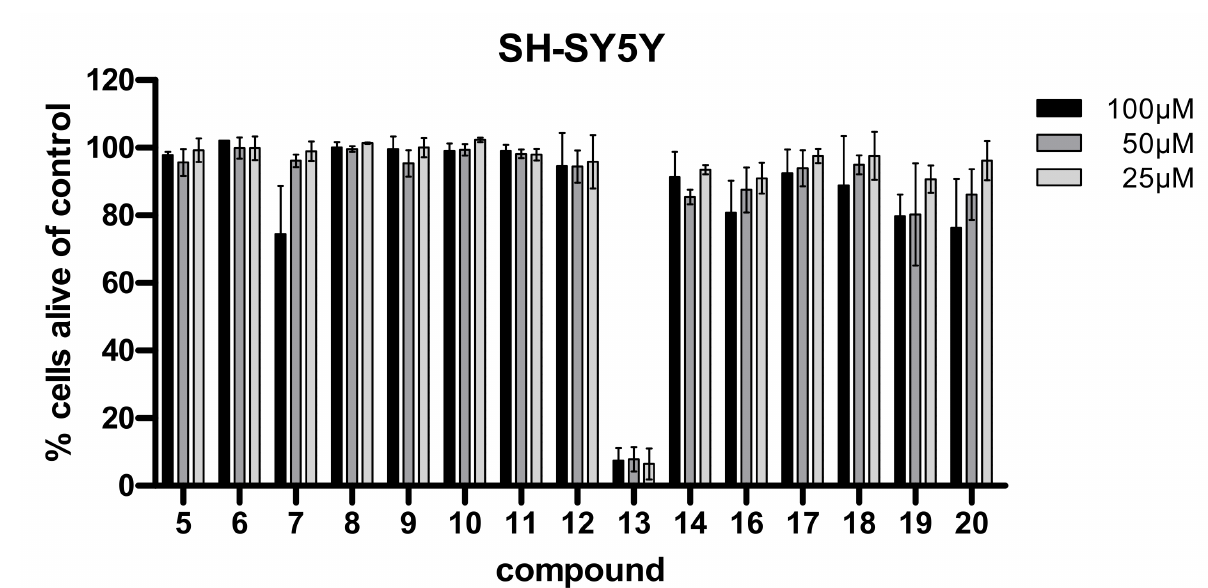
Figure 6. Viability of neuroblastoma cell line SH-SY5Y after treatment with different concentrations (100/50/25 µ M) of the indicated compounds for 24 h.